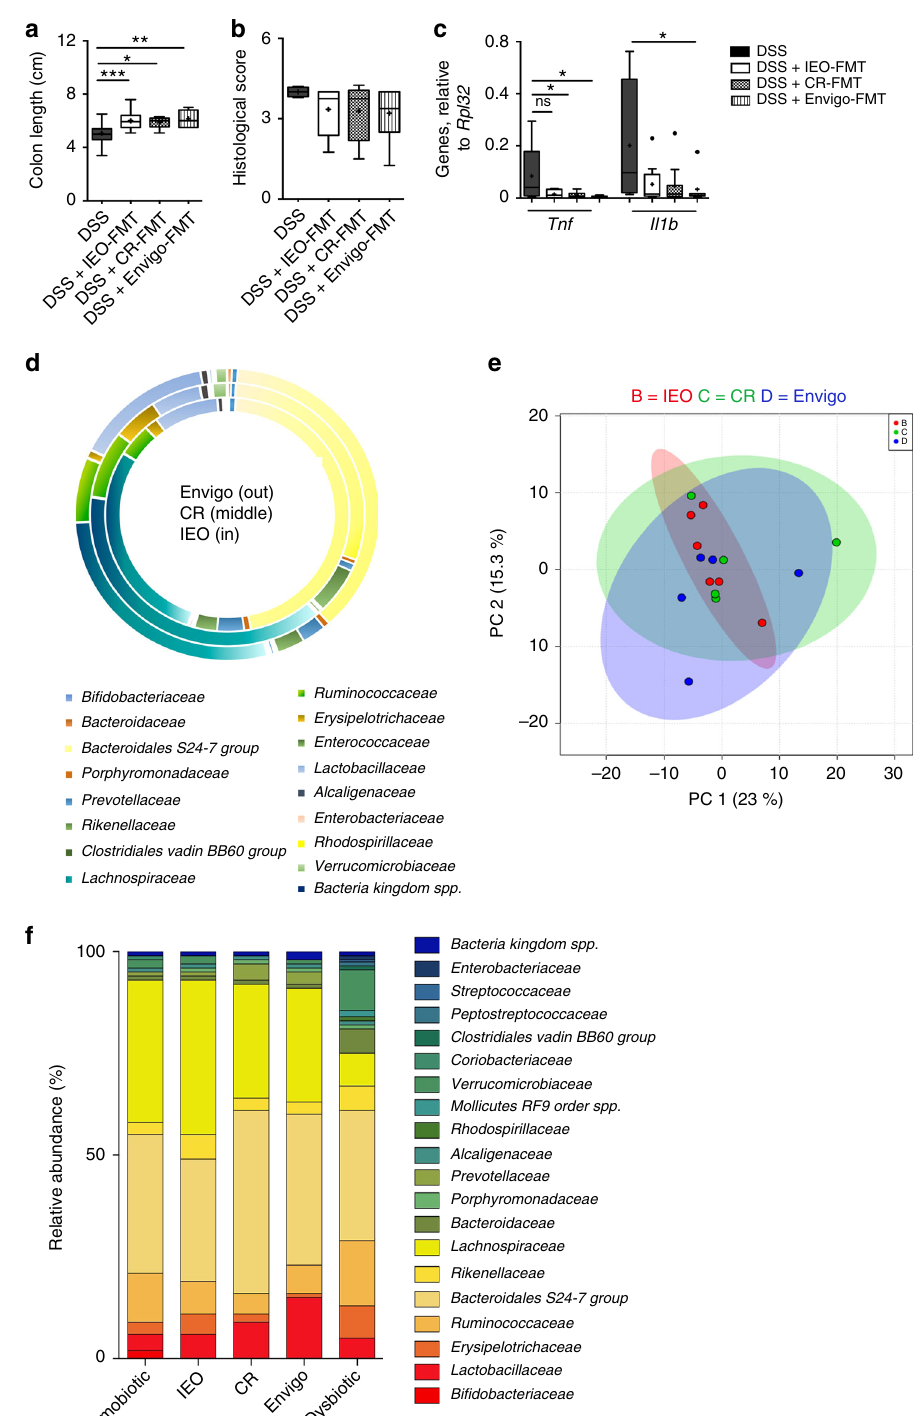
histological score (4b) and expression of colonic pro- in fl ammatory genes (Fig. 4c) As previously observed 11,39,40 , donor mice sharing the same genetic background, sex and age, but raised in different animal facilities harbored a microbiota genetically similar, not identical, (Fig. 4d, and Supplementary fi g 5b) but capable to perform overlapping metabolic activities (Fig. 4e). In accordance to very recent data 41 , 90 to 93% of the total taxa relative abundance of normobiotic mice, regardless of its origin, was composed by a